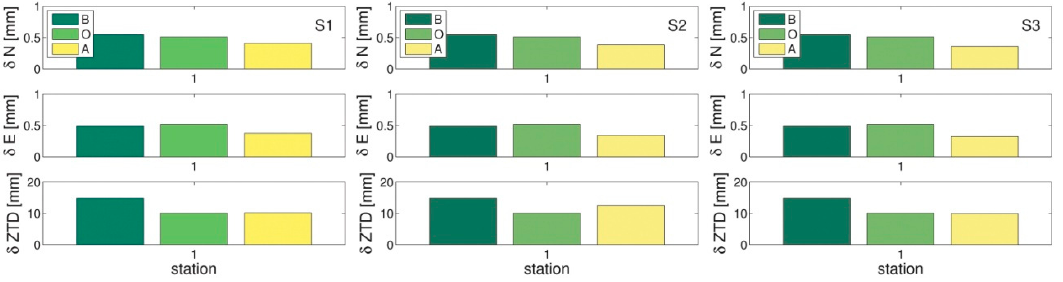
Figure 6. Same as Figure 3 but data from the station network are assimilated.